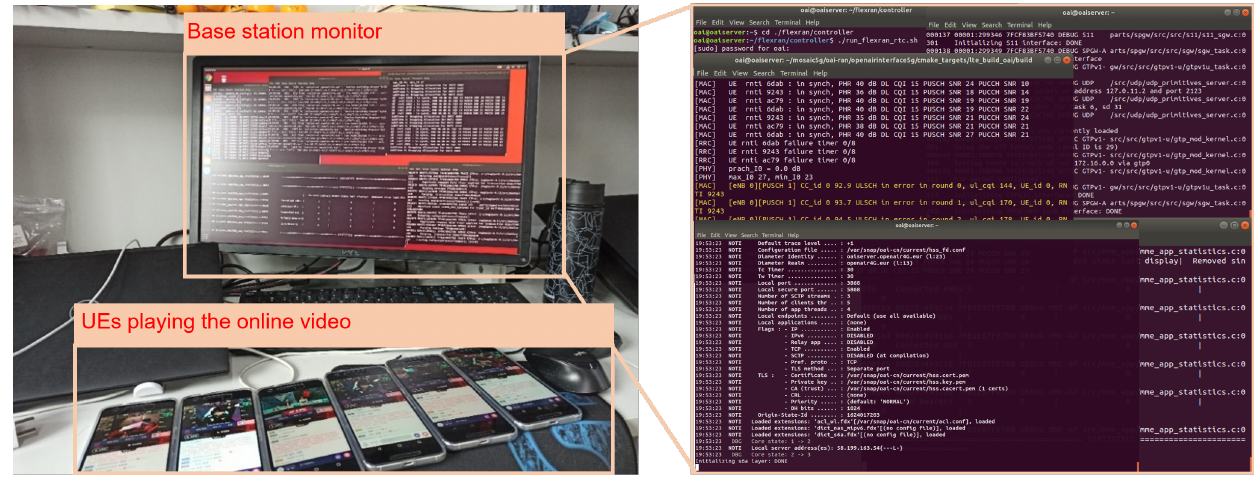
Figure 8. The neighbor base station is working. The UEs are playing the online video to occupy the bandwidth. The monitor shows the running status of the base station.